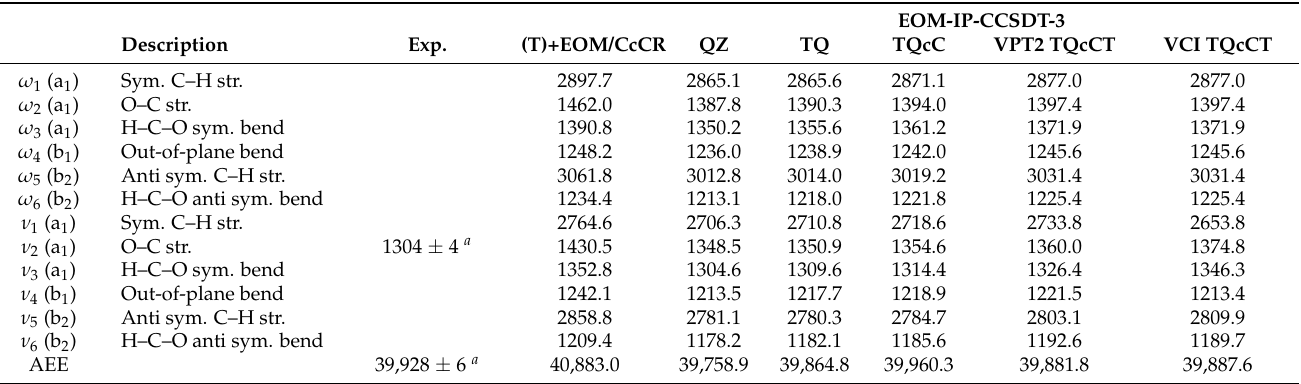
Table 10. ˜B 2 A 1 H 2 CO + Vibrational Frequencies in cm − 1